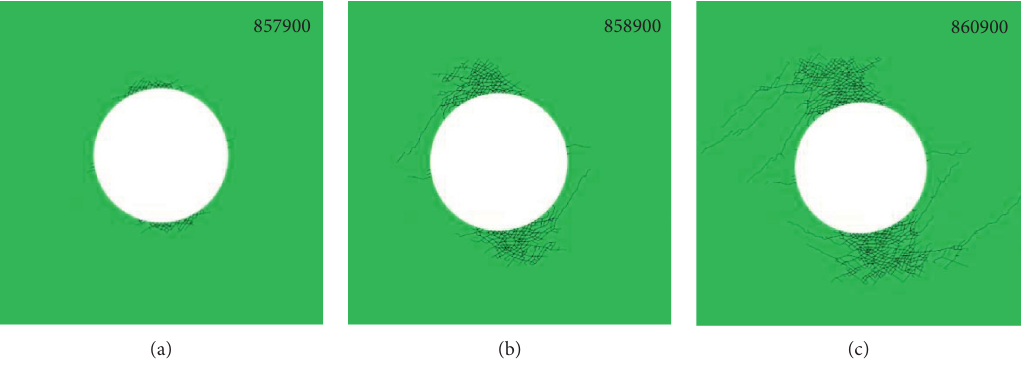
Figure 10: The simulated crack propagation process in studying size effects.